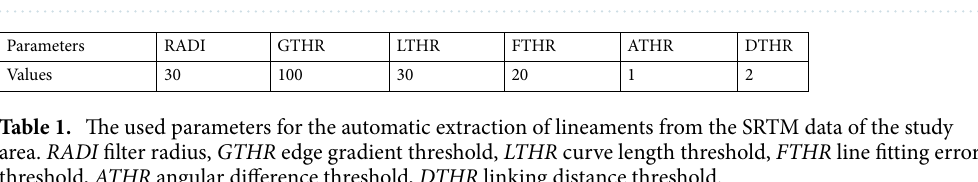
Figure 5. Shaded-relief map computed from Shuttle Radar Topography Mission data of Ife-Ilesha schist belt utilizing a 45 degree light angle at azimuths 337.5 degrees. Shuttle Radar Topography Mission image courtesy of the U.S. Geological Survey. The figure was produced using ArcMap Software version 10.8 (Website: https:// deskt op. arcgis. com/ en/ arcmap/).